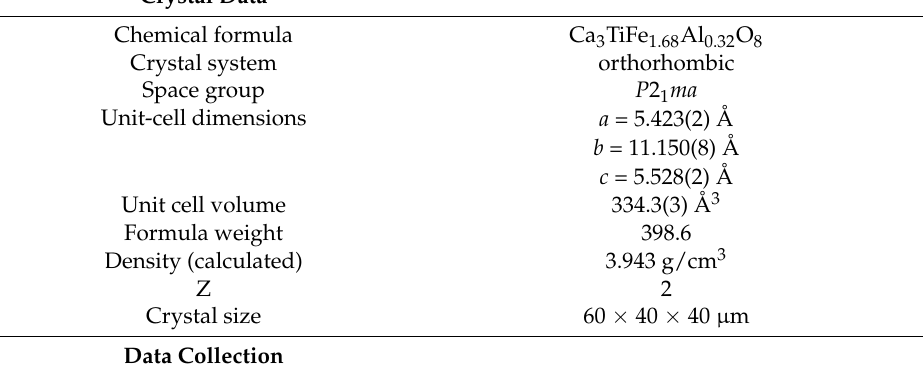
Table 2. Parameters for X-ray data collection and crystal-structure refinement for sharyginite. Crystal